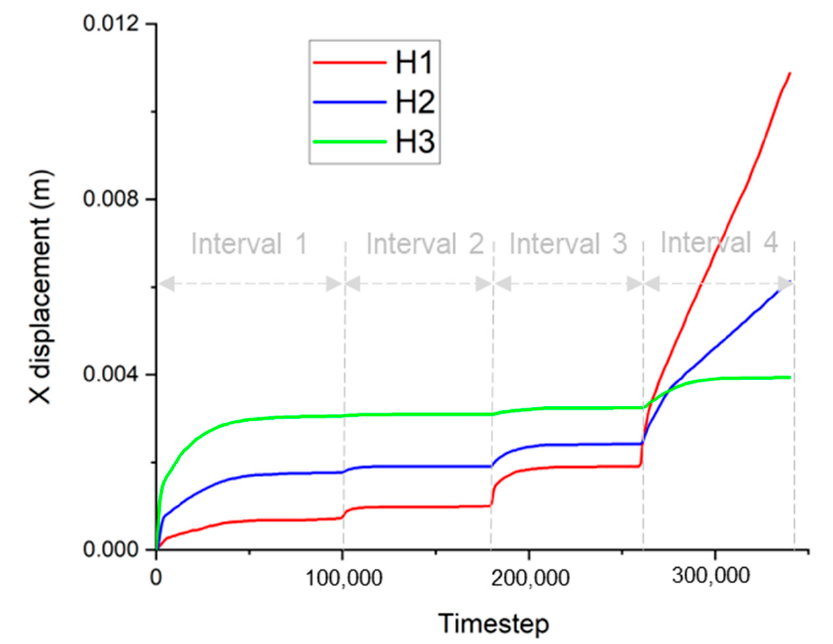
Figure 14. X displacement of 3 history points (H1, H2 and H3) against calculation timestep.